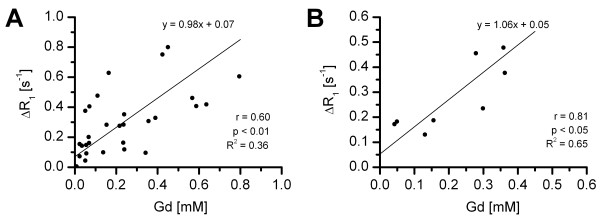
Correlation between regional ΔR1 and Gd concentration. Correlation between regional ΔR1 values determined by in vivo CMR and Gd concentration determined by ex vivo ICP-MS. The analysis was done either on all individual heart segments (A) or after averaging all values in each heart slice (B).